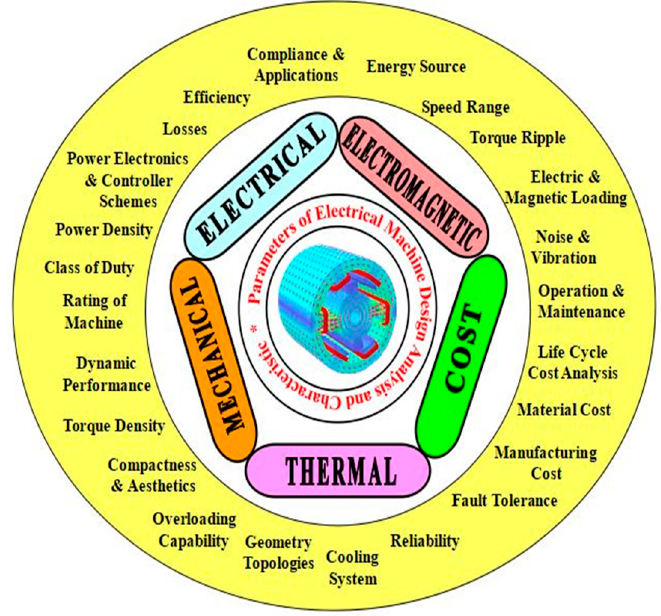
Figure 6. Electrical machine design parameters for analysis and characteristics studies.